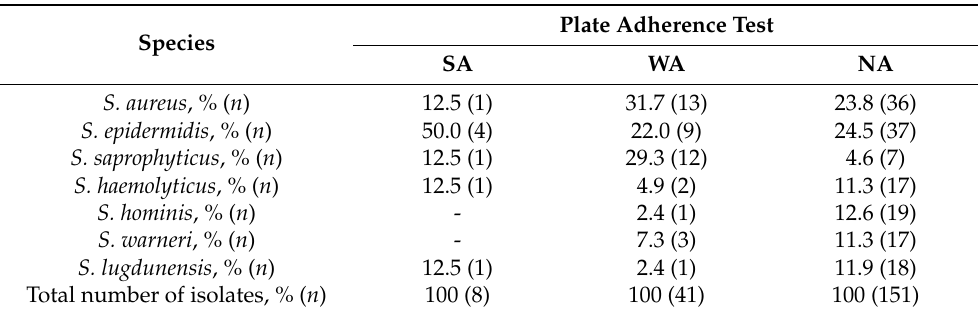
Table 1. Identification of biofilm-producing Staphylococcus spp. isolates using the polystyrene plate adherence method.